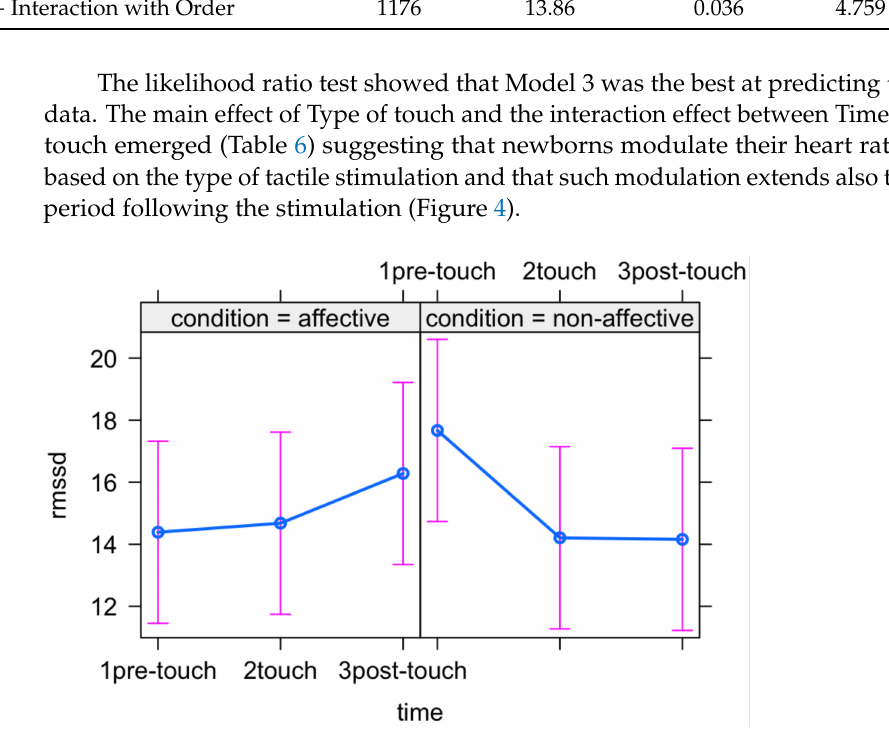
Figure 4. Plot of the interaction effect between Time and Type of touch. Mean (blue dots) and standard errors (pink lines) are displayed for each time point (pre-stimulation, stimulation and post-stimulation) in the two experimental conditions (affective and